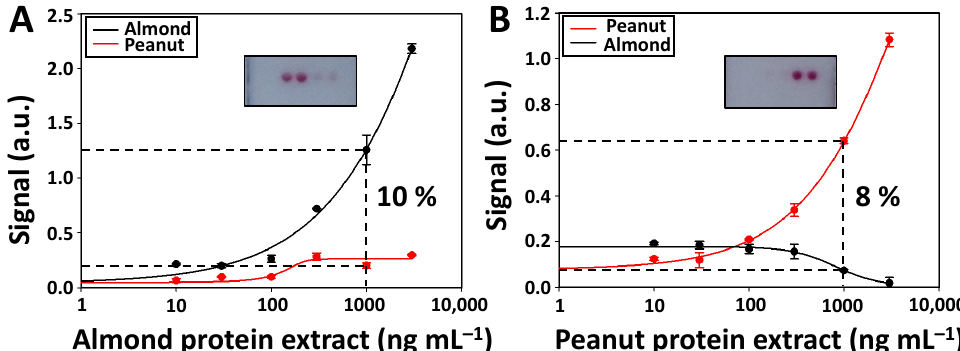
Figure 4. Cross-reactivity (%) between the assays corresponding to the first test zone (row 1) when analyzing 1000 ng mL − 1 of ( A ) almond and ( B ) peanut protein extract. Inset showing the picture of the first test zone (row 1) after performing the cross-reactivity assay with 1000 ng mL − 1 of almond and peanut protein extract. The signals correspond to the mean value of 3 replicates, while the error bars show the standard deviation.